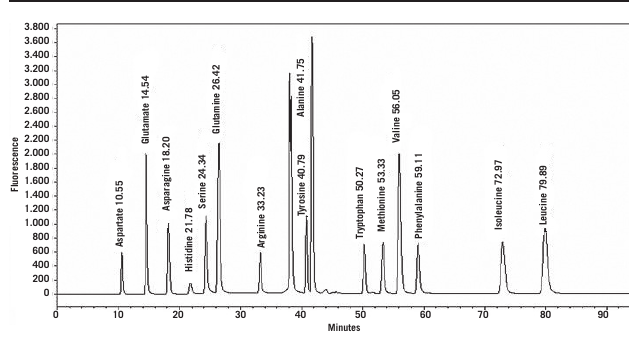
figurE 1 − Determination of amino acids in aqueous matrix by HPLC Aspartate (100 nmol/ml), glutamate (250 nmol/ml), asparagine (25 nmol/ml), histidine (100 nmol/ml), serine (140 nmol/ml), glutamine (350 nmol/ml) arginine (150 nmol/ml), tyrosine (180 nmol/ml), alanine (350 nmol/ml), tryptophan (150 nmol/ml), methionine (100 nmol/ml), valine (250 nmol/ml), phenylalanine (180 nmol/ml), isoleucine (180 nmol/ml) and leucine (250 nmol/ml). HPLC: high performance liquid